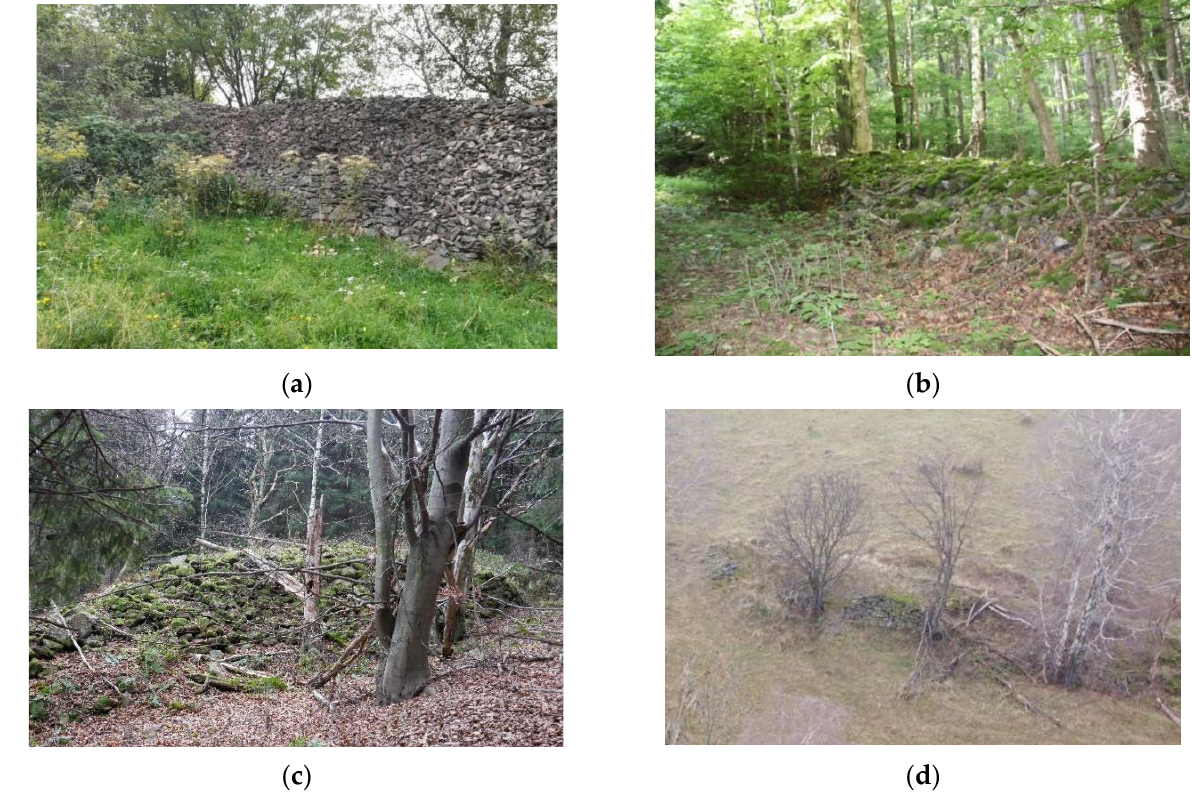
Figure 9. Stone walls: ( a ) Hřibová 50.3468017N, 17.0068733E; ( b ) Kamenné 50.2874683N, 17.0471761E; ( c ) Hřibová 50.3465264N, 17.0137519E; ( d ) Hřibová 50.3478356N, 17.0129886E .